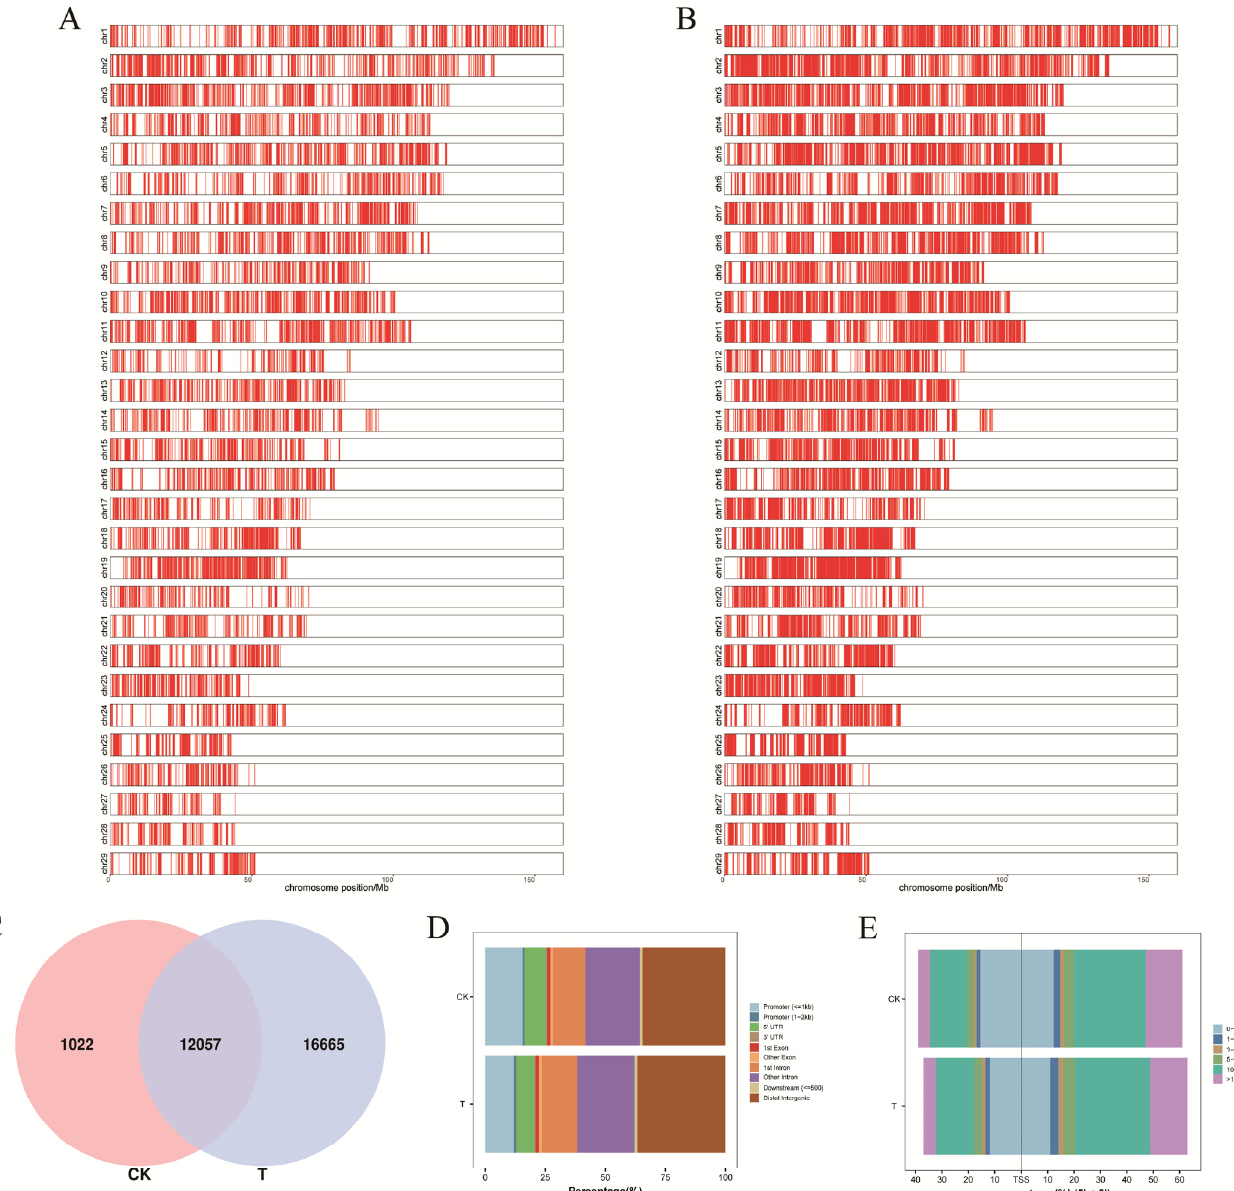
Figure 4. Analysis of the peaks in the CK and T groups. ( A , B ) Distribution of all peaks in chromosomes location landscape in the CK and T groups, respectively. ( C ) Venn diagram showing the overlapping peaks between the CK and T groups. ( D ) Location distribution of common peaks on the different regions of genome (promoter, 5 ′ UTR, 3 ′ UTR, exon, intron, downstream and distal intergenic) in CK and T group. ( E ) Common peaks relative TSS distance distribution ratio map in CK and T group.